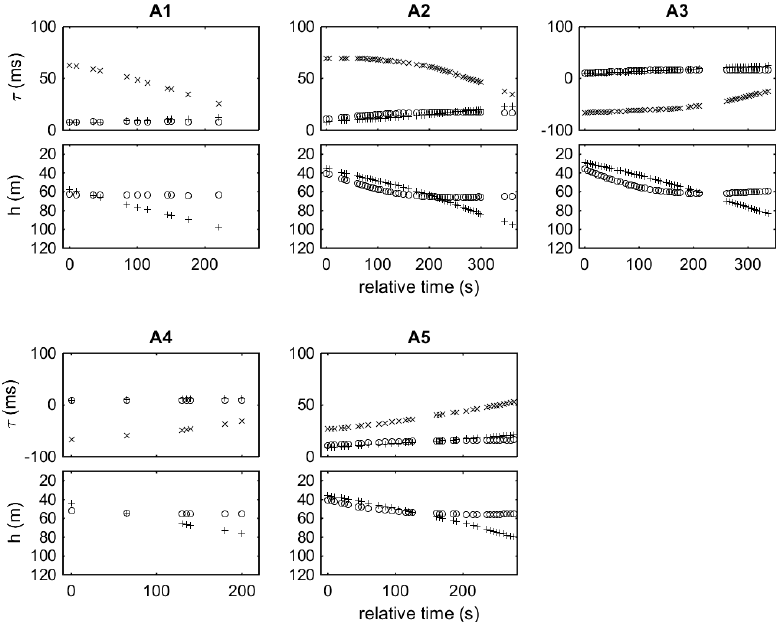
Figure 7. TDOAs and hydrophone depths during stations A1–A5 of the shallow-water experiment for  front hydrophone ( ◦ ), rear hydrophone (+) and 21